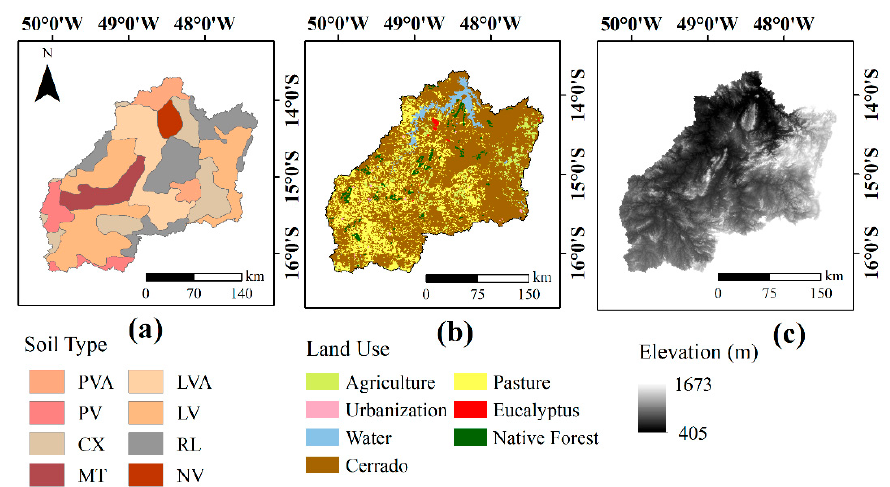
Figure 3. Spatial distribution of ( a ) soil types ( b ) and land cover, and ( c ) Digital Model Elevation (DEM) of the SMB.